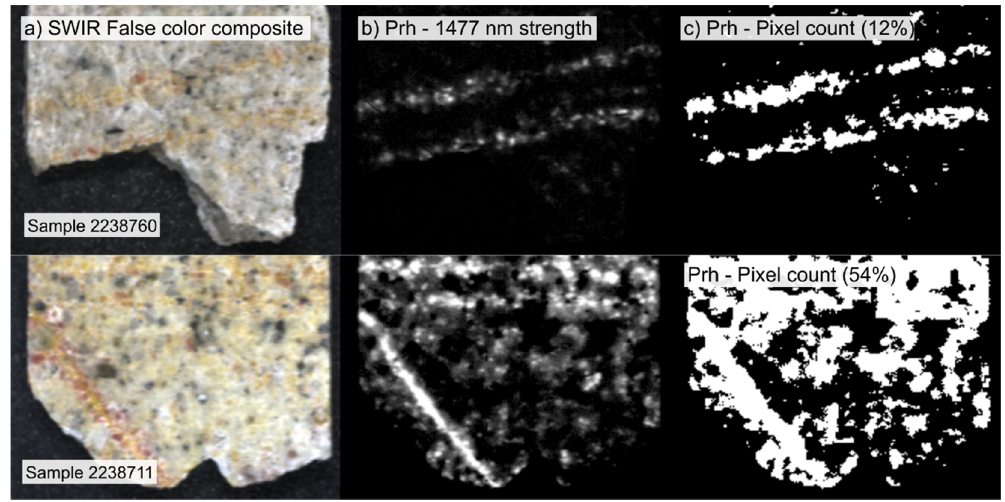
Figure 4. Relative abundance pixel count example. ( a ) False color shortwave infrared (SWIR) imagery. ( b ) Processed hyperspectral image showing the relative strength of the second derivative of the 1477 nm absorption, indicating the presence of prehnite. ( c ) Pixel count of the image shown in ( b ), indicating 12% of the total pixels contain prehnite for the top sample, and 54% for the bottom sample.